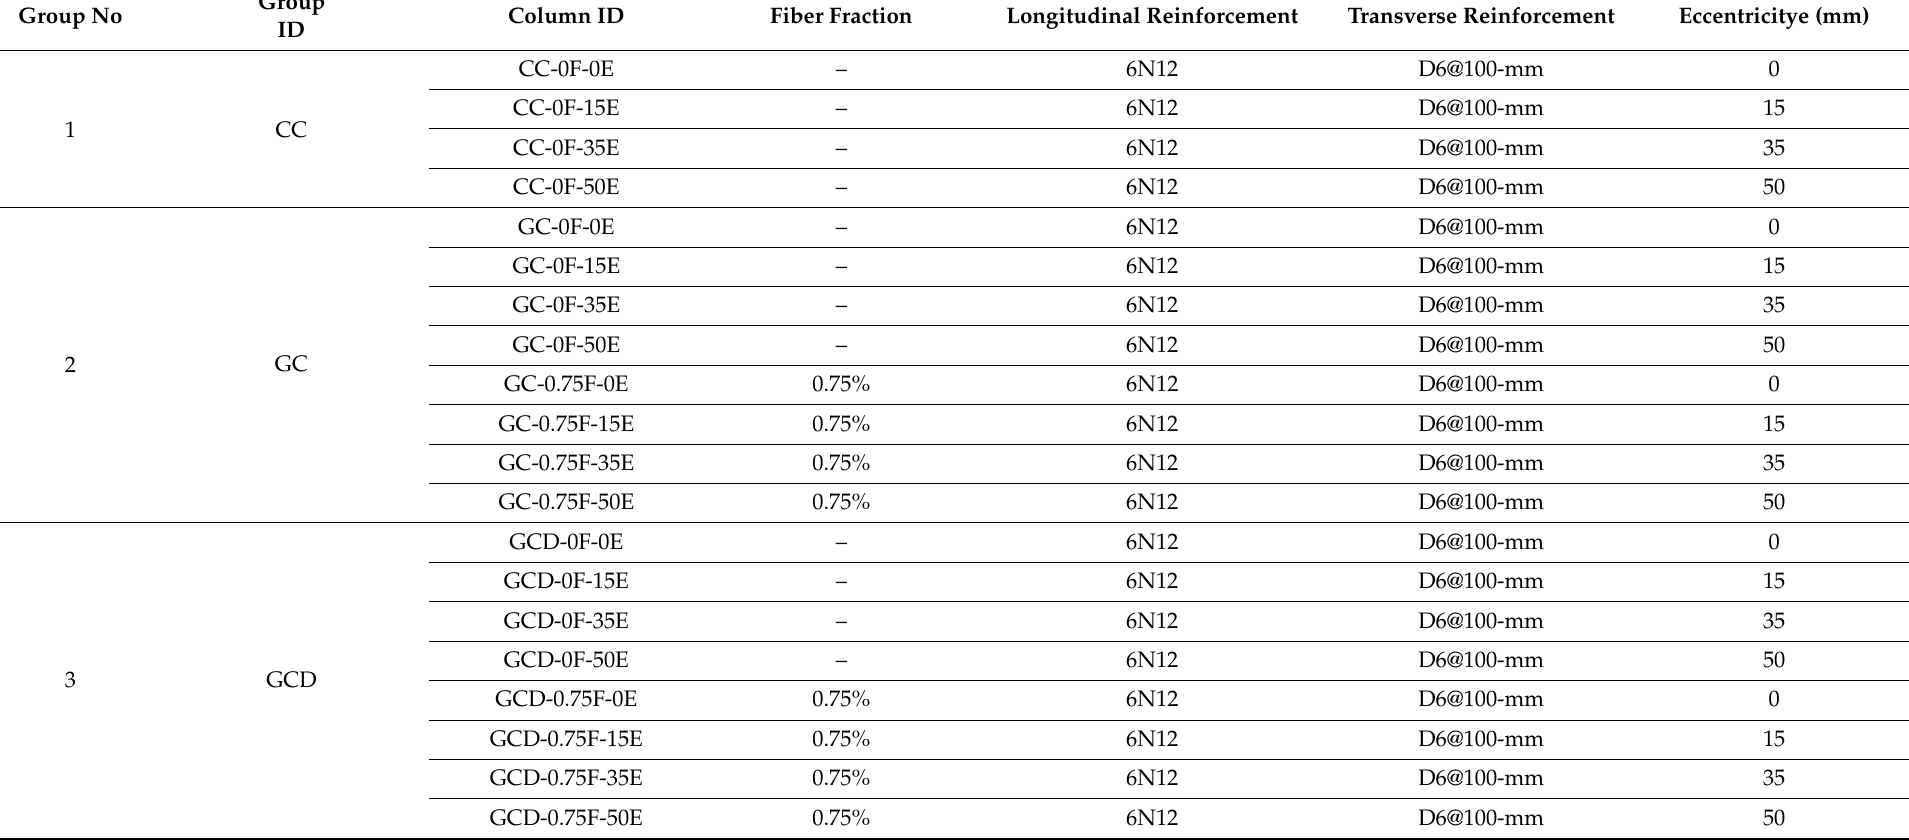
Table 2. The details of column specimen groups, reinforcements, and the loading